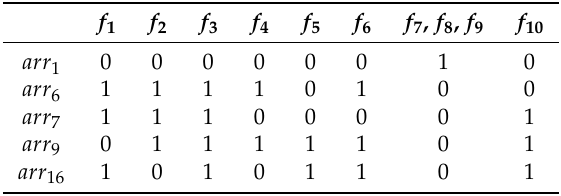
Table 2. Fault diagnosis system of the fault detection and isolation (FDI) system designed.